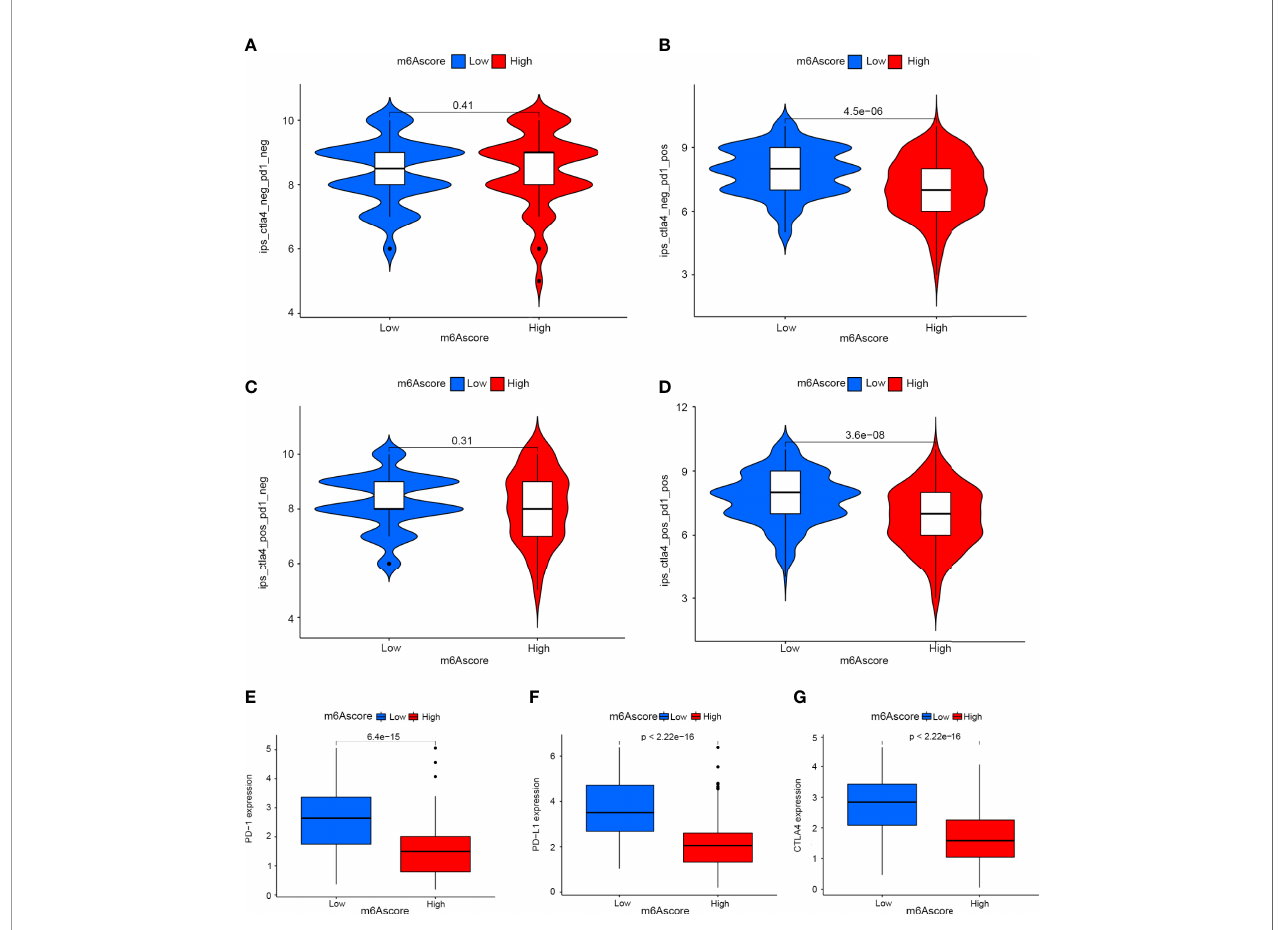
FIGURE 7 | The role of m6A-scoring signature in immunotherapy. (A – D) The comparison of the relative distribution of immunophenoscore (IPS) between low and high m6A score groups. (E – G) Expression of immune checkpoints among low and high m6A score